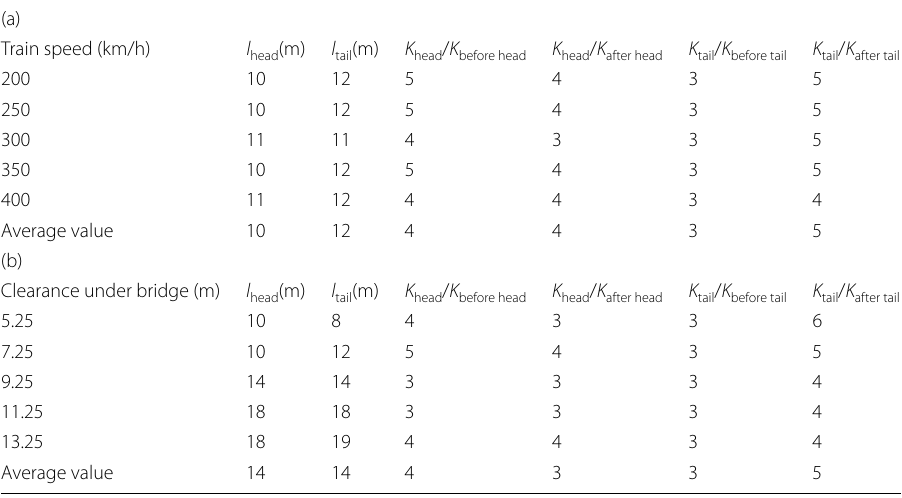
Table 3 Wind pressure curve parameters: (a) different train speeds; (b) different clearances under